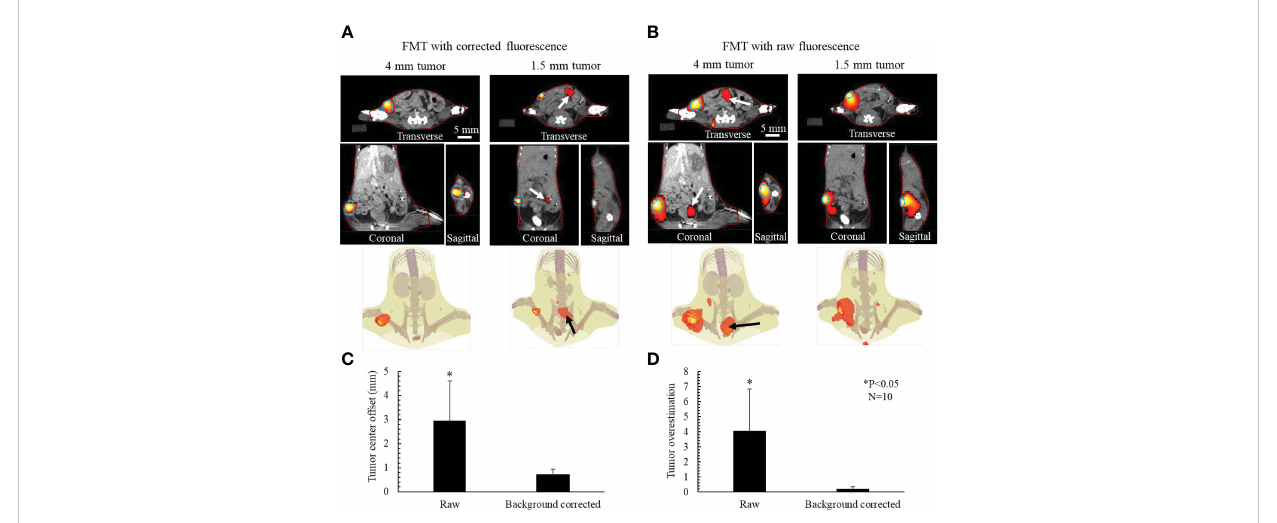
FIGURE 9 Active-targeting FMT reconstruction respectively based on AMBS-corrected (A) and raw (B) fl uorescence, for 2 (out of 10) mice bearing breast tumors with different sizes. Blue dotted line delineates the tumor edge obtained from CT. FMT (red colorwash) is superimposed on CT. Red line denotes the mouse contour used in FMT reconstruction. Bottom rows in (A, B) show the 3D rendering of FMT in the CT bony anatomy. Arrows in (A) point to the reconstructed residual uptake in gut. Arrows in (B) point to the artifacts caused by the nonspeci fi c fl uorophore update in abdomen. (C) Mean tumor center offset and (D) tumor volume overestimation for the 10 mice